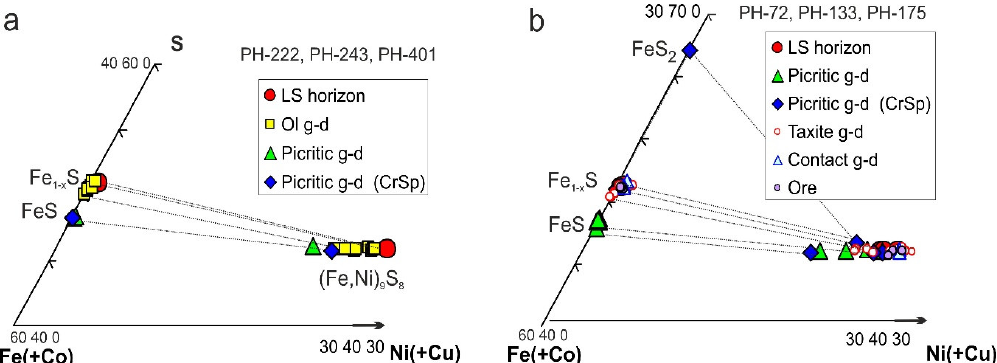
Figure 5. Composition of sulfides in the Fe(+Сo) – Ni–S system: ( a ) boreholes in which the lower layered series is represented by olivine gabbro-dolerites; ( b ) boreholes in which the lower layered series is represented by taxite gabbro-dolerites.